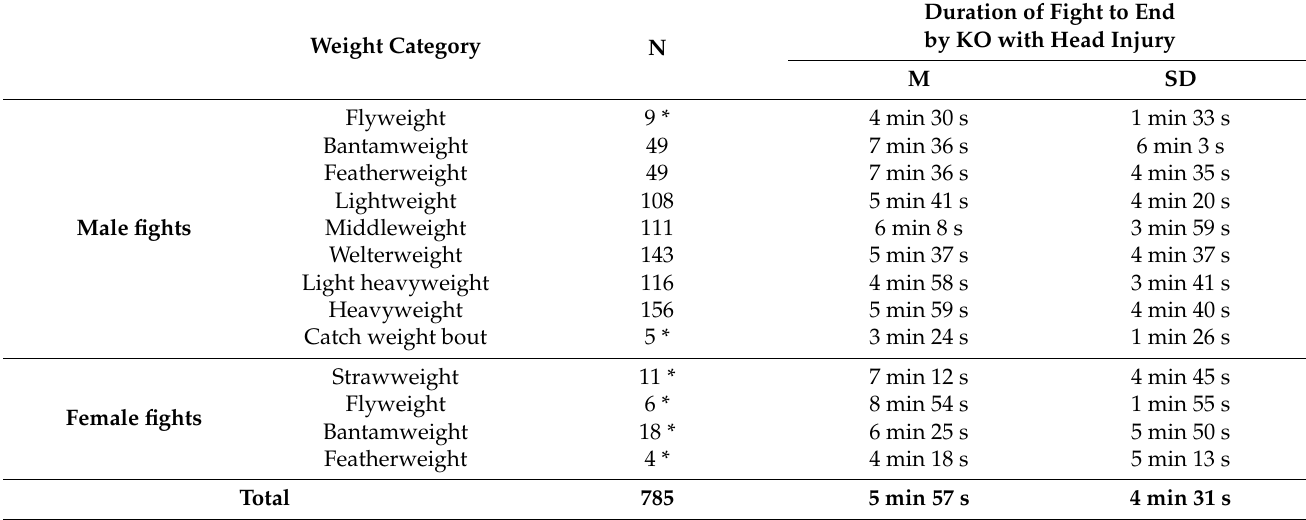
Table 4. The duration of a fight ended by KO with a head injury depending on the weight